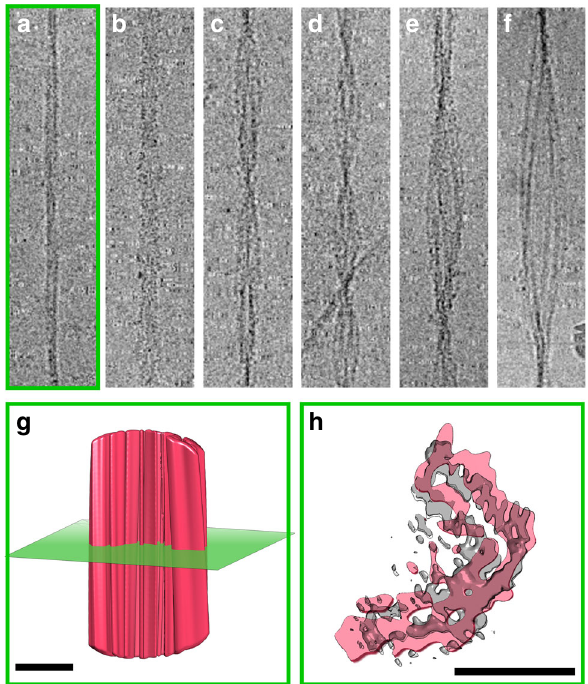
Fig. 6 Variety in fi bril morphology. Six different morphologies were identi fi ed in the non-entangled fi brils constituting the cryo-EM dataset. These range in size from apparent single proto fi laments ( a ), through a series of apparent two proto fi lament fi brils ( b – d ), the structure of one of which has been described here at 3.9 Å resolution (panel c ), to assemblies of multiple proto fi laments ( e , f ). Each panel ( a – f ) is 500 Å wide. Side view ( g ) and cross-section through ( h ) a low-resolution reconstruction of morphology ( a ) showing density consistent with an L-shaped subunit. Each scale bar in panels ( g ) and ( h ) is 50 Å in